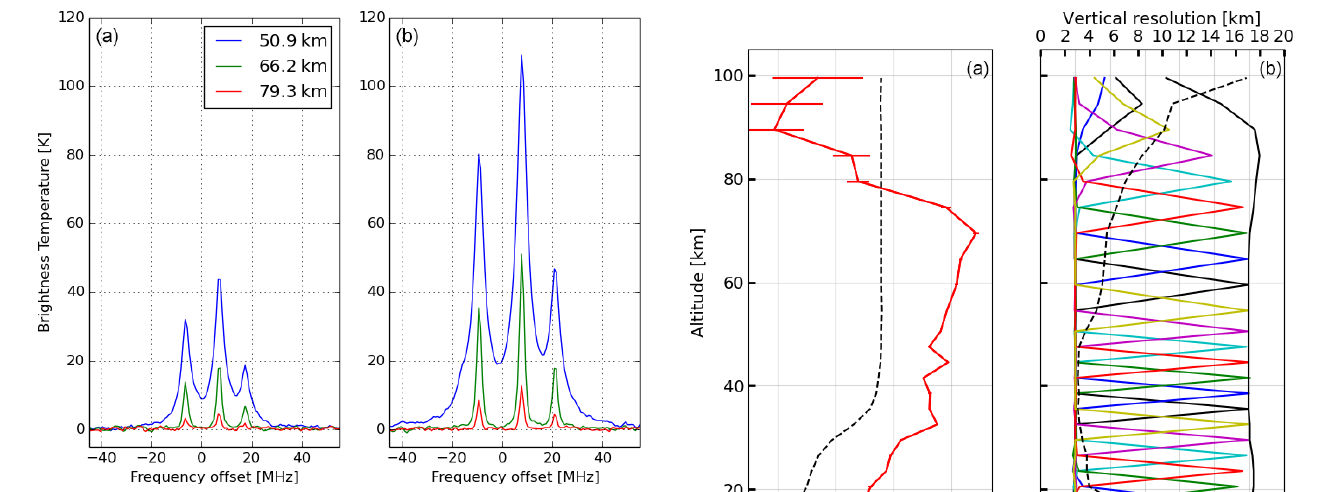
Figure 2. (a) An example of the H 37 Cl spectra observed by SMILES from a single-scan measurement. Tangent heights are ap- proximately 50, 65, and 80km. Center frequency is 624.98GHz. (b) An example of the H 35 Cl spectra for the same condition as for the H 37 Cl spectra. Center frequency is 625.92GHz. Table 2. Spectroscopic line parameters measured in the laboratory and used in the processing.